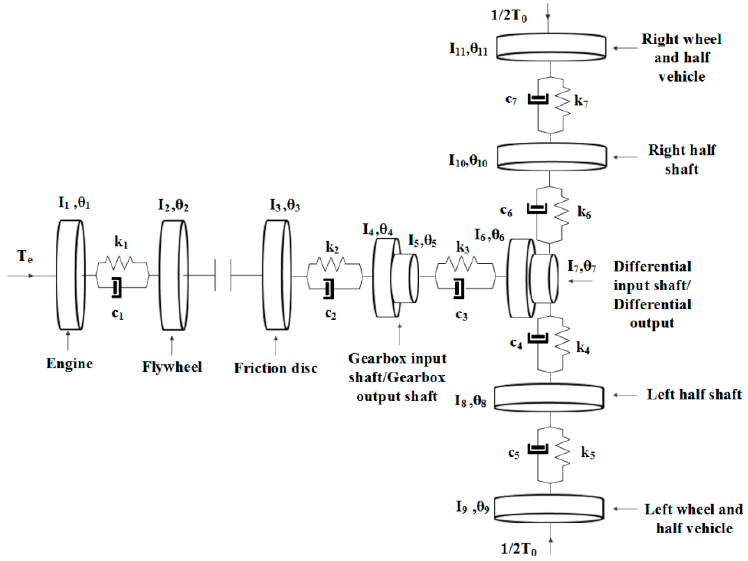
Figure 1. Schematic representation of the extended 9-DOF clutch dynamic model to the whole vehicle drivetrain system.